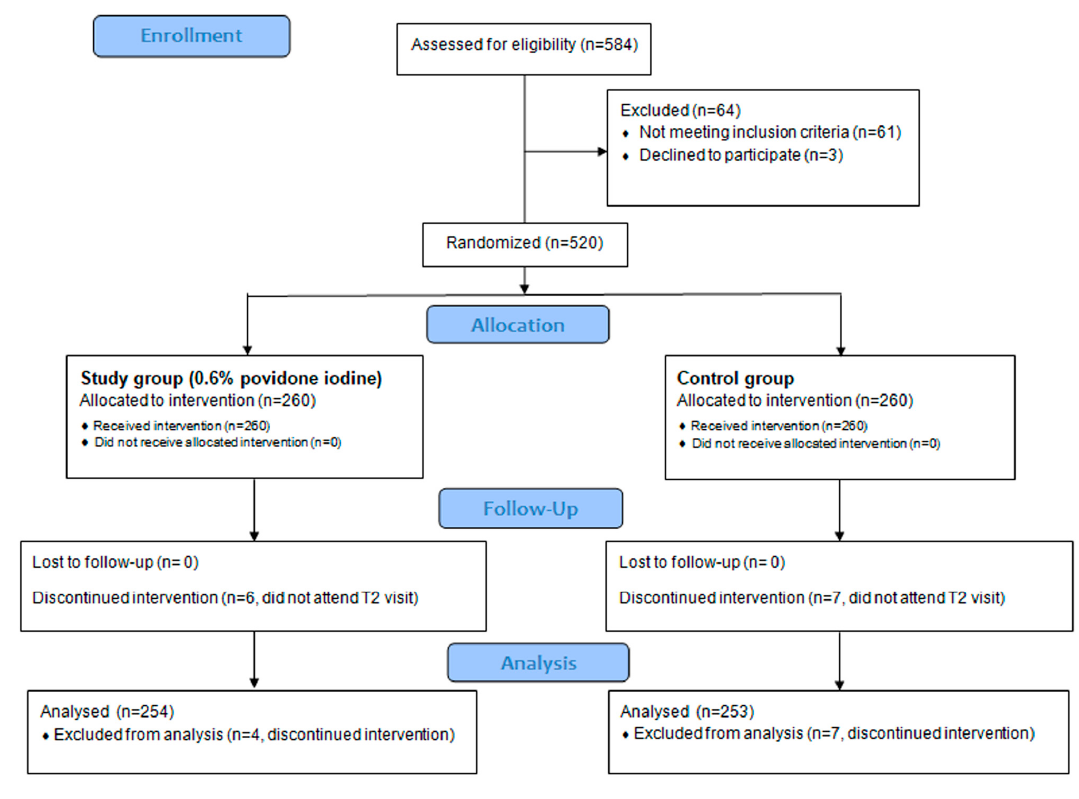
Figure 1. Recruitment flowchart. Table 1. Characteristics of study